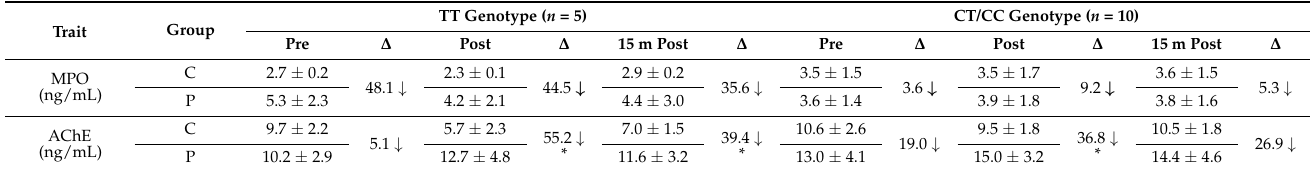
Table 2. Percent change of MPO and AChE levels in caffeine and placebo condition in ADORA2A C allele and TT genotype